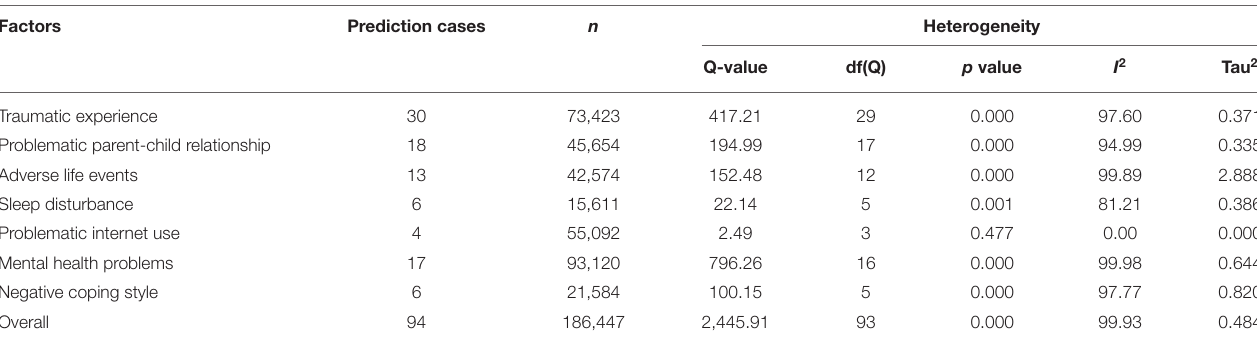
TABLE 1 | The results of homogeneity